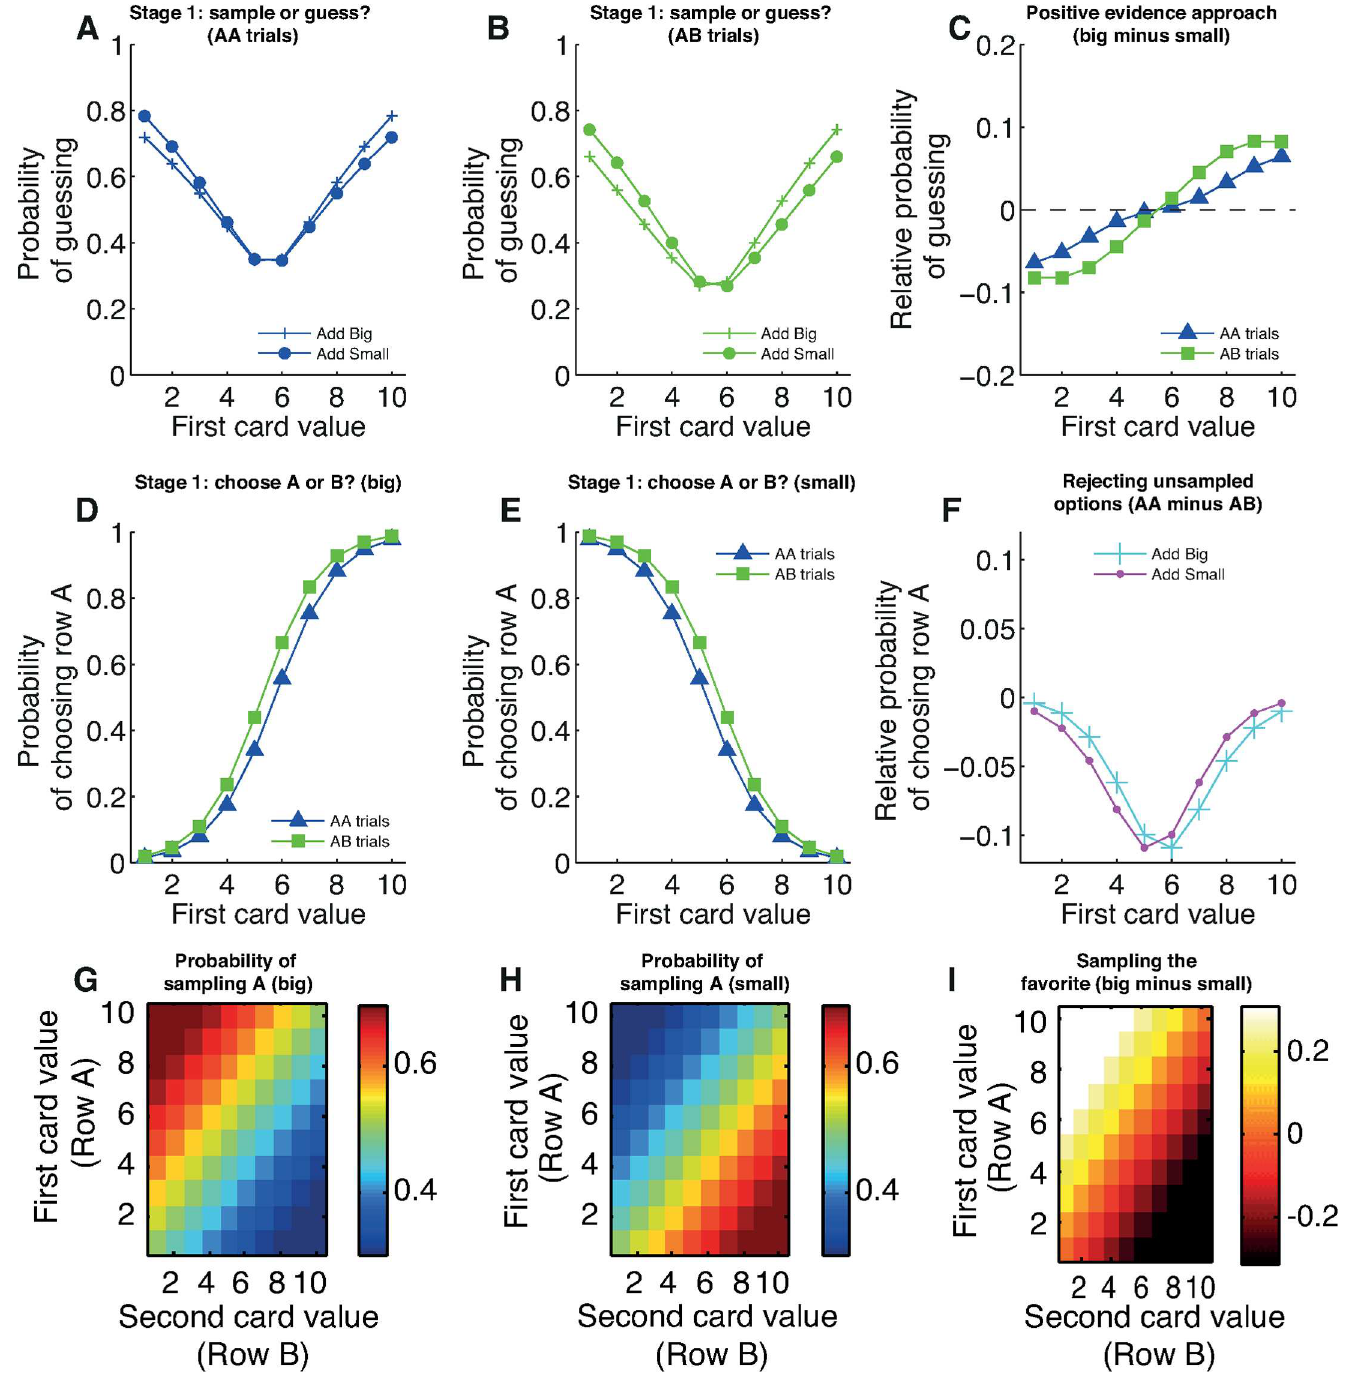
Fig 5. Behavioral predictions from the full parametric model of subject behavior, with best-fit parameters. (A) Predicted probabilityof guessing at stage 1 for AA trials (compare to Fig 2Bi) and (B) AB trials (compare to Fig 2Bii) in “add” condition. (C) Predicted “positive evidenceapproach” bias. Compare to Fig 2C. (D) Predicted probability of choosingrow A, having chosen to guess, at stage 1, for “add big” (compare to Fig 3Bi) and (E) “add small” (compare to Fig 3Bii) conditions. (F) Predicted “rejecting unsampledoptions” bias. Compare to Fig 3C. (G) Predicted probabilityof samplingrow A in “big” (compare to Fig 4Bi) and in (H) “small” (compare to Fig 4Bii) conditions. (I) Predicted “samplingthe favorite” bias. Compare to Fig 4C. See also S9 Fig. Data for reproducing all analysesis freely availablefor download from